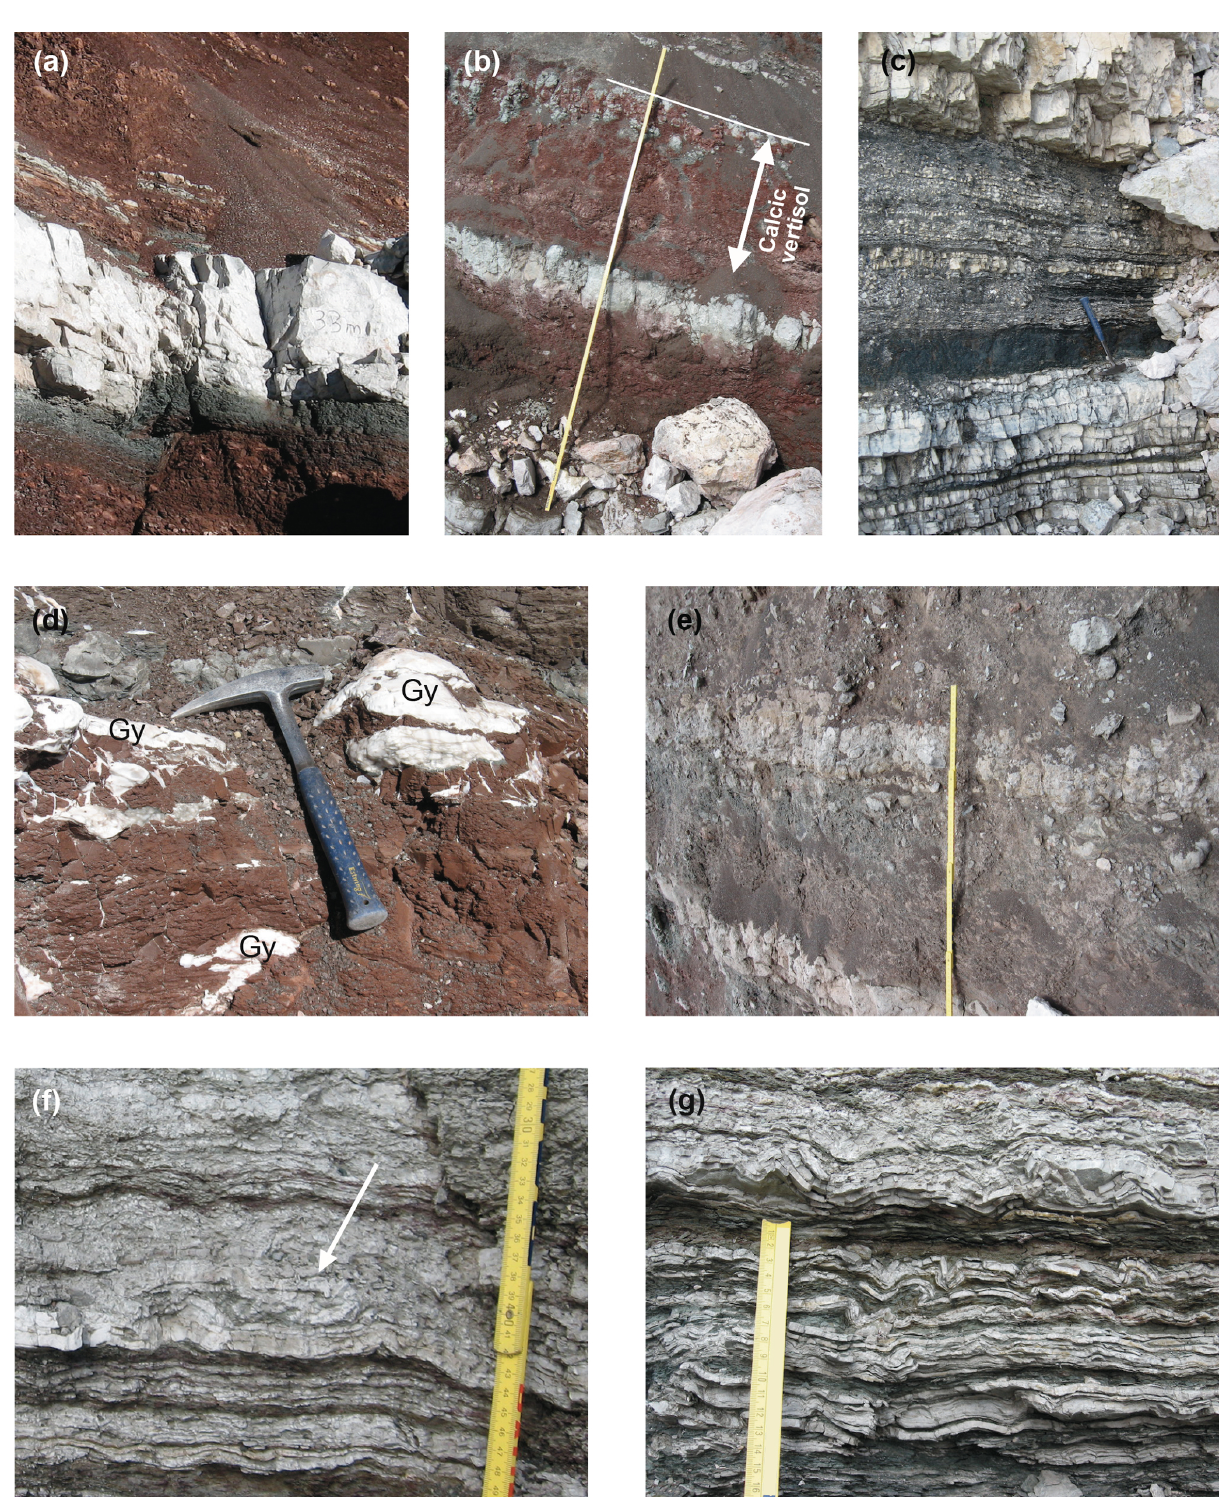
Figure 3. Outcrop images of different types of dolomite intercalated with red and grey clay of the Travenanzes Fm. at Rifugio Dibona: (a) homogeneous dolomite bed (15cm thick; 33m). (b) Upper part: dolomite nodules embedded in red clay, cross-cut by green-coloured cracks that are part of a calcic Vertisol (95m). (c) Laminated dolomite (110–112m) interbedded with grey clay. (d) Bed containing gypsum nodules (Gy), along with gypsum-filled cracks at 50m; (e) Dolomite-cemented conglomerate bed at 75m. (f) Laminated bed showing soft sediment deformation (106m); an isoclinal synsedimentary fold is indicated by the arrow. (g) Laminated dolomite showing folding of the laminae due to soft sediment deformation (same bed as in f